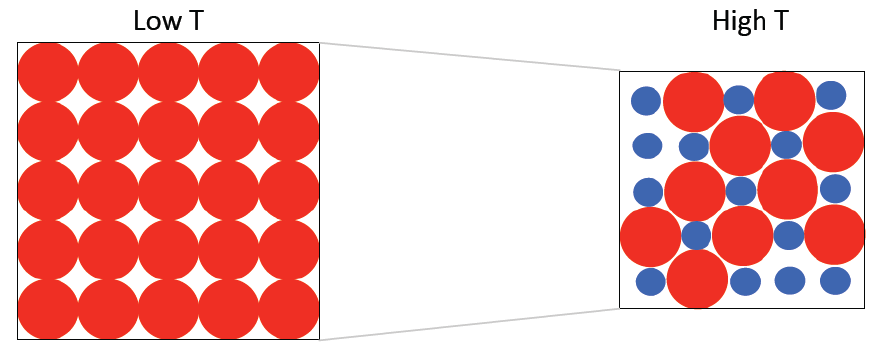
Figure 5. Schematic illustration of how volume contraction occurs in the Weiss two-state picture. The overall volume of the system is reduced as more atoms are excited to the small-volume state at higher temperature. This effect is in competition with the usual volume expansion due to the anharmonic effect of lattice vibrations. The fraction of small-volume atoms is exaggerated for visual effect in this